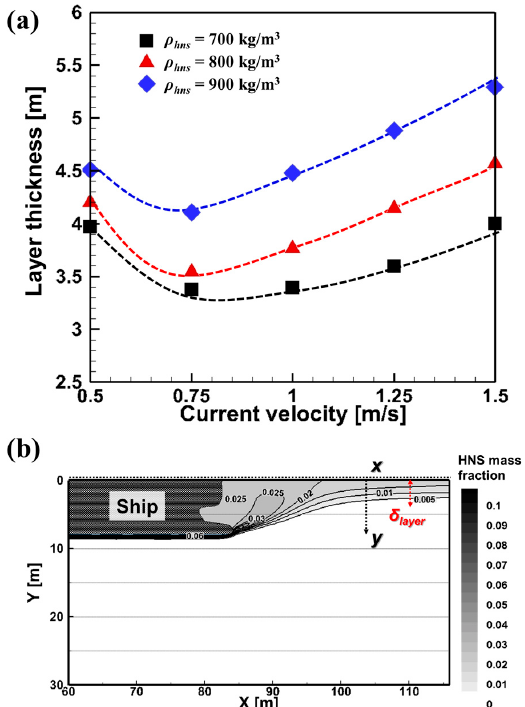
Figure 5. ( a ) The change in the HNS layer thickness for the input variables ( v c and ρ hns ), and ( b ) the schematic of the HNS layer thickness. schematic of the HNS layer